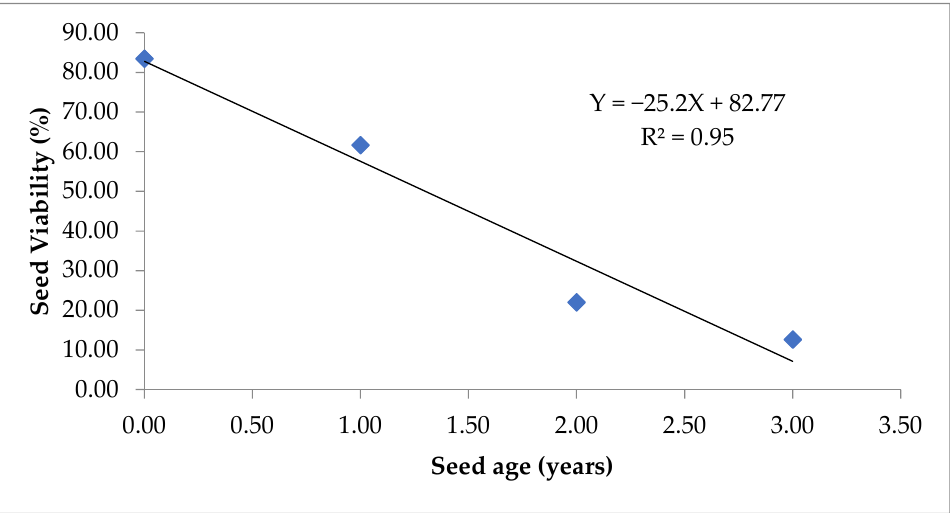
Figure 4. Simple linear regression between seed age and seed viability (%).